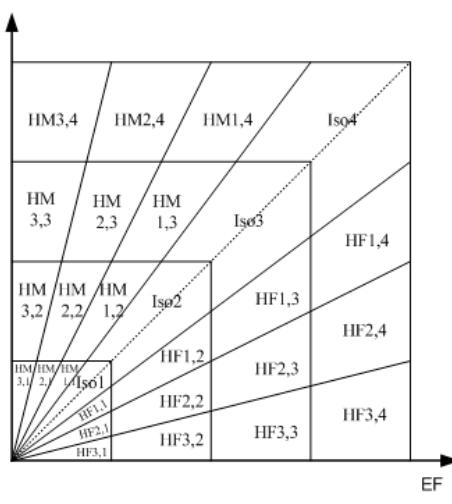
Figure 7 . Final fields formed by the intersection of the angle and distance variables Note . Angle variable: HM3, HM2, HM1, ISO, HF1, HF2, HF3. Distance variable: fields varying from the 1 (next to the origin) to 4 (extreme field).